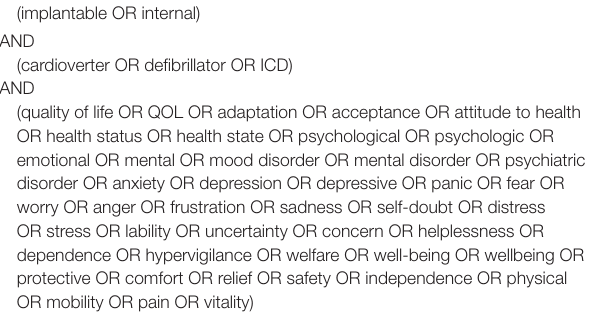
TABLe 2 | The databases and the field search settings used.